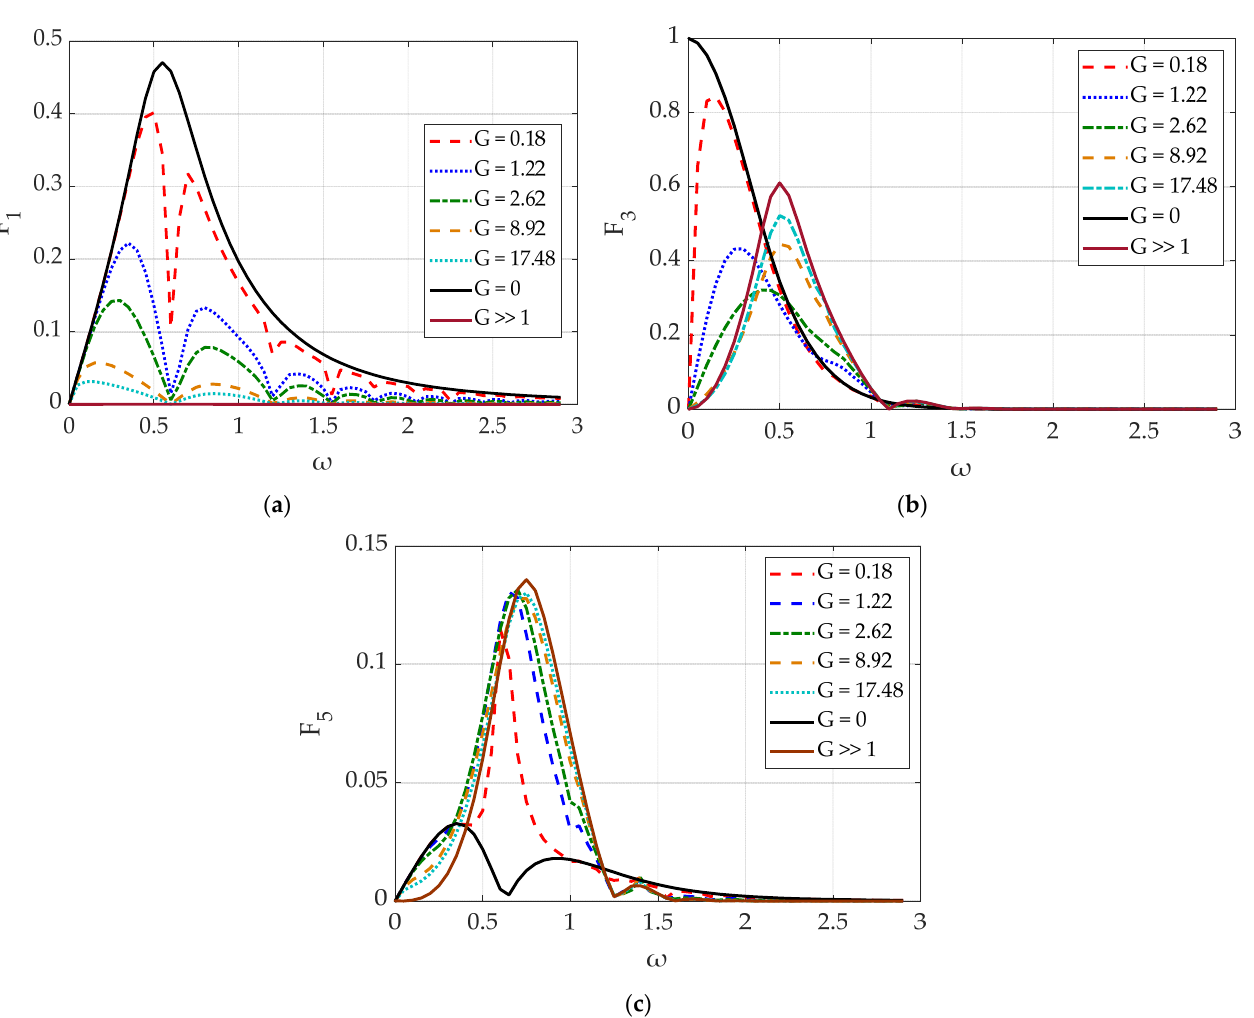
Figure 5. Dimensionless exciting forces F 1 ,F 3 , F 5 on the permeable cylindrical body against wave frequency ω for various values of porous effect parameter G = 0.18, 1.22, 2.62, 8.92, and 17.48: ( a ) F 1 ; ( b ) F 3 ; ( c ) F 5 . Here, G = 0 and G (cid:29) 1 cases are also